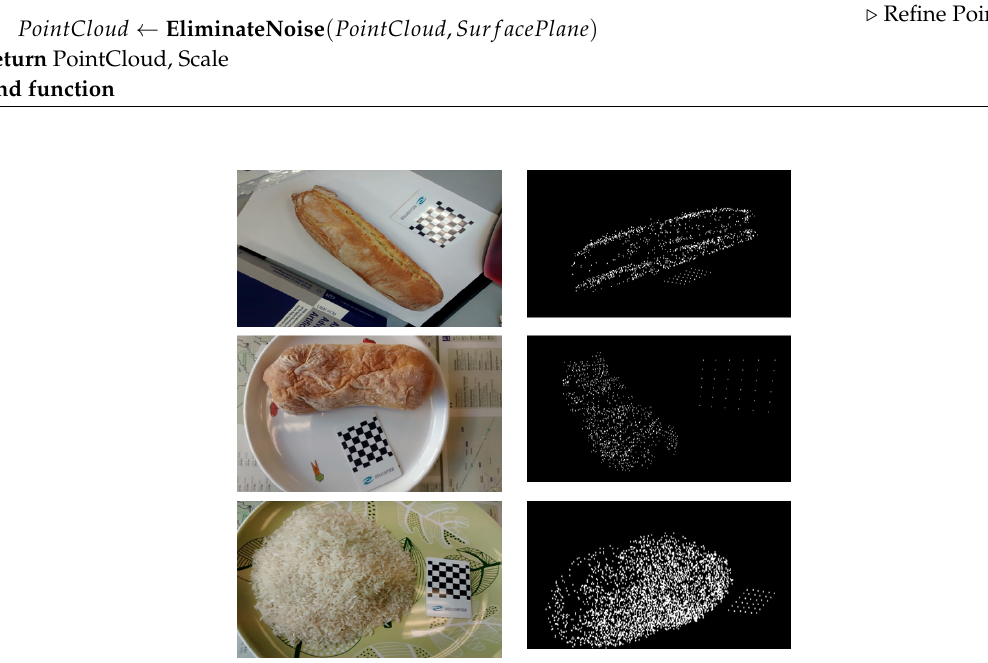
Figure 6. Three examples of models reconstructed by the proposed